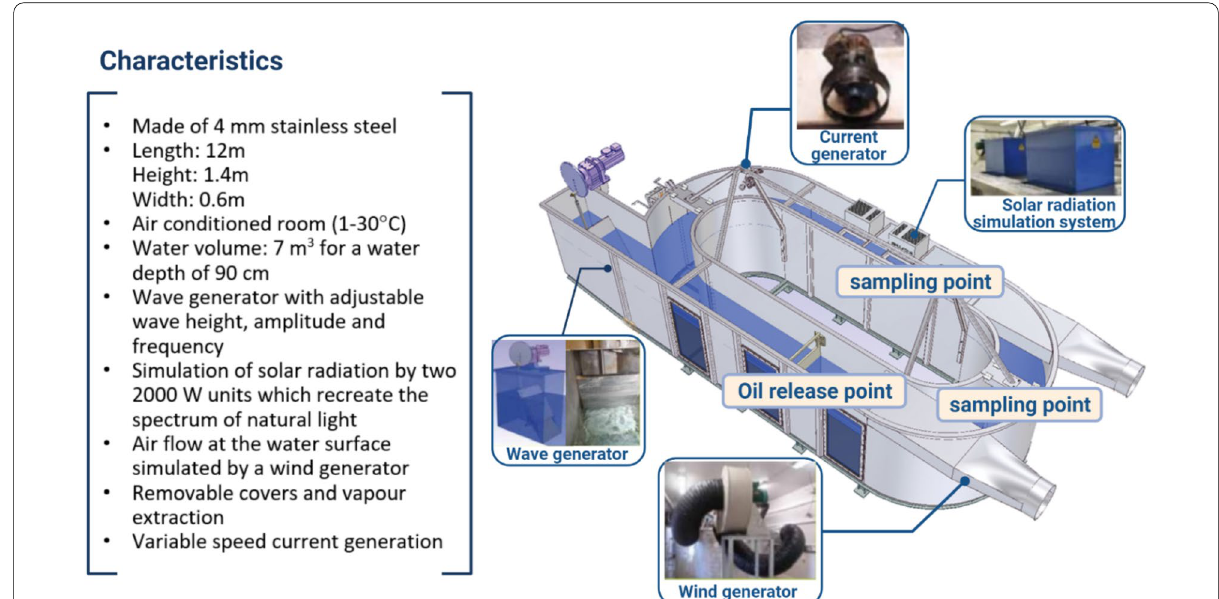
Fig. 1 Main feature of Cedre’s circulating flume. The components include stream generator, solar radiation generator, wave generator, and wind generator (Cedre